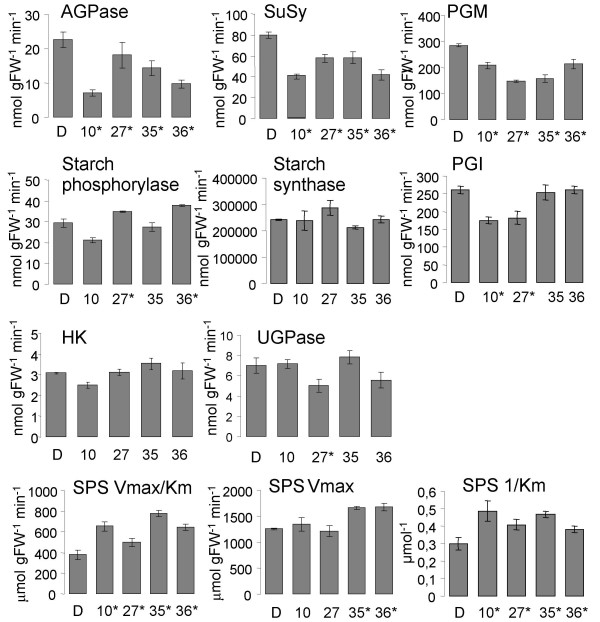
Enzyme activities. The activity of enzymes involved in sucrose and starch metabolism in tubers of control (D) and HD1 plants. Enzyme activities were measured in the same tuber's samples as the one used for carbohydrate, catecholamine and metabolite analysis. Data represent the mean ± SE of determination on three individual plants per line. Asterisks (*) indicate values that are significantly different from the wild type plants. SPS – sucrose phosphate synthase; UGPase – UDPglucose pyrophosphorylase; AGPase – ADPglucose pyrophosphorylase; SuSy – sucrose synthase, PGM – phosphoglucomutase; PGI – phosphoglucoisomerase; SS – starch synthase